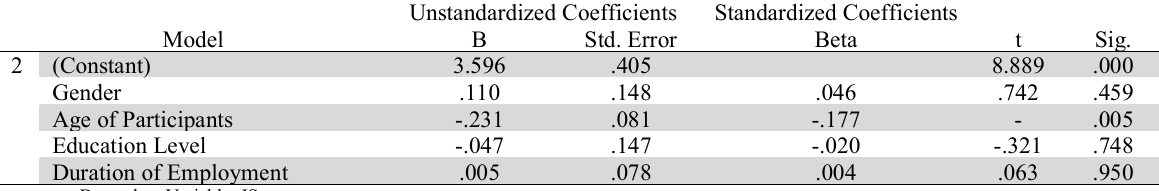
JS against demographic variables – analysis of Coefficients a